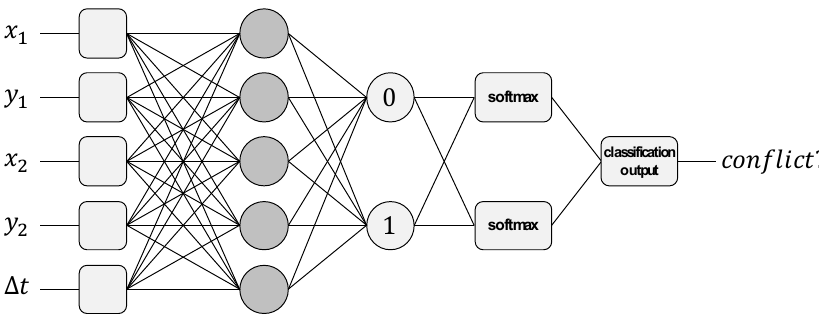
Figure 10. Neural network 5 × 2 .